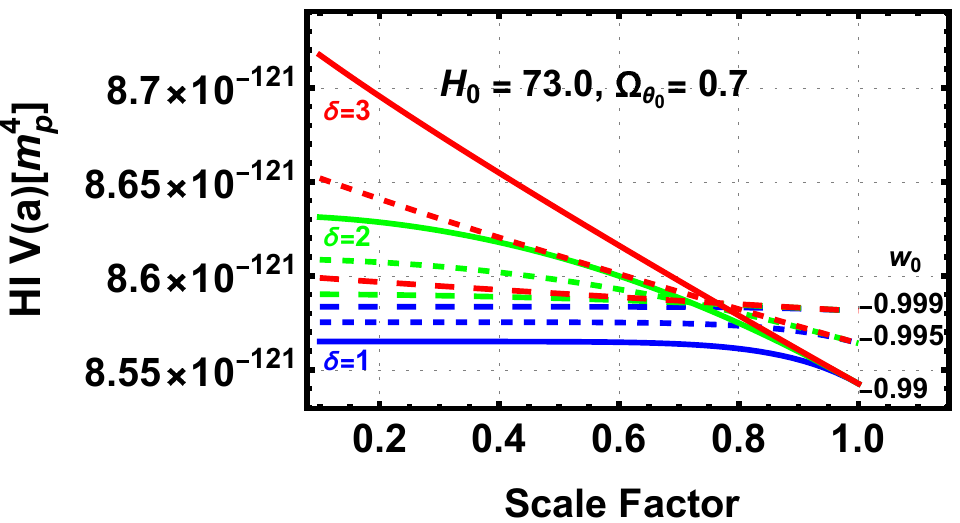
Figure 6. The figure shows the evolution of the HI dark energy potential for all cases in this study. Figure 6 shows that there is only a small evolution of the potential between scale factors of 0.1 and 1.0, again consistent with a slow roll. The maximum evolution is 1.7% for the δ = 3 w 0 = − 0.99 case. The δ = 1 evolutions are essentially constant, mimicking Λ CDM, until a scale factor of ≈ 0.7, and then decrease slightly to the a = 1.0 value for w 0 = − 0.99 and − 0.995. The δ = 2 cases deviate from constant evolution earlier than the δ = 1 cases, and the δ = 3 cases have almost linear evolution and have the highest values, particularly at small scale factors. All of the w 0 = − 0.999 cases have a very flat evolution. For a given value of w 0 , the current value of the potential is the same for all δ values. From Equations (10) and (37) the potential at a scale factor of one is 3 H 0 ( Ω θ shows that the value of the beta function at a scale factor of 1 is the same for a given w 0